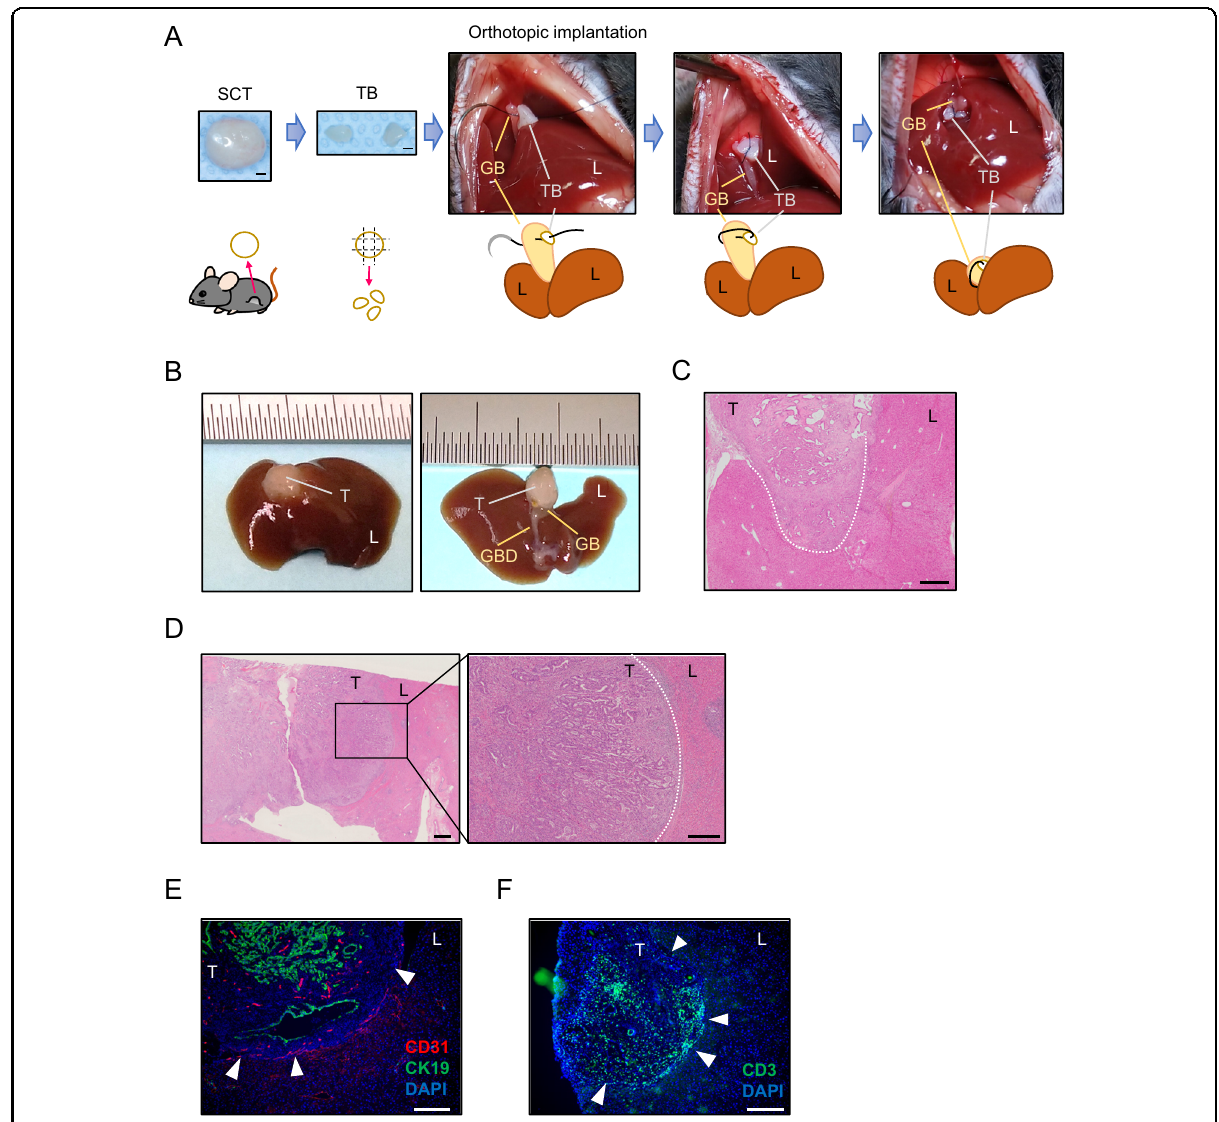
Fig. 3 Development of an orthotopic and syngeneic gall bladder (GB) cancer model. A A typical work fl ow of the orthotopic GB cancer model. A subcutaneous tumor (SCT) was cut into 3-mm fragments (tumor bud: TB) and sutured directly to the outer surface of the GB of a C57BL/6 J mouse. Scale bar, 1 mm. L indicates the liver. B The macroscopic fi ndings of an orthotopic GB cancer. Left panel, replacement of the GB by the tumor (T). Right panel, a reversed view of the GB tumor, and the common bile duct (CBD). C Hematoxylin and eosin (H&E) staining of the tumor. Direct invasion of cancer cells into the liver tissue (white dotted line). Scale bar, 200 μ m. D H&E staining example of a human GB cancer is shown. The borderline of the tumor and liver is indicated by a white dotted line. Scale bar, 2 mm (left), 500 μ m (right). E Immuno fl uorescence staining of the tumor. Vascular endothelial cells (red, CD31) and epithelial cells (green, CK19) are stained. Note that angiogenesis is observed in the liver tissue adjacent to the tumor surface (arrowheads). Scale bar, 200 μ m. F Immuno fl uorescence staining of T cells. Note that the T cells (green, CD3) are in fi ltrating the tumor boundary (arrowheads) in contact with the liver. Scale bar, 200 μ